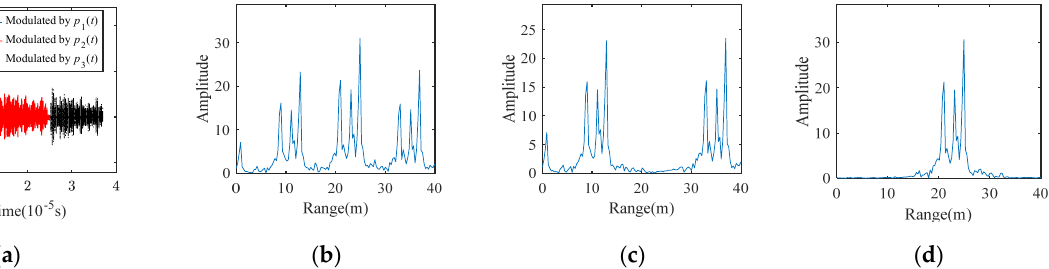
Figure 9. Measurement results: ( a ) Echo in the anechoic chamber; ( b ) Range profile of the first segment of echo; ( c ) Range profile of the combined echo; ( d ) Range profile after cancellation.